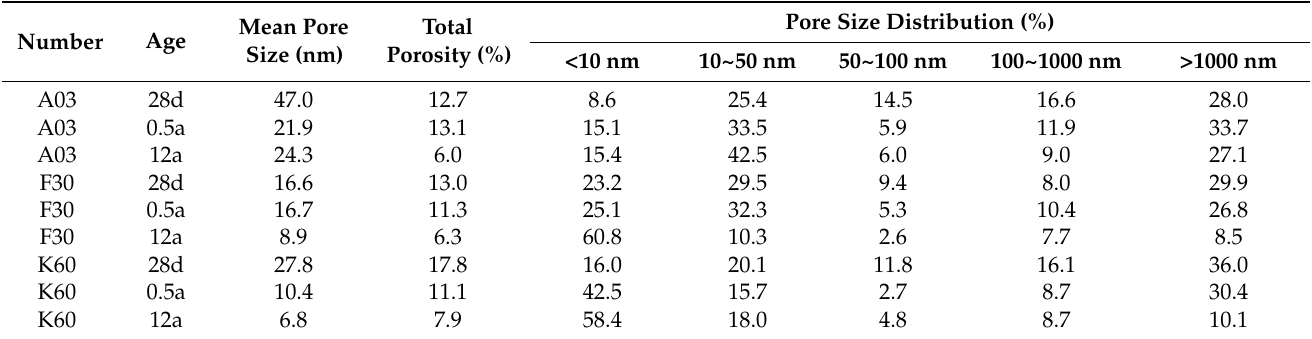
Table 8. Characteristic Parameters of Pore Structure of Concrete at Different